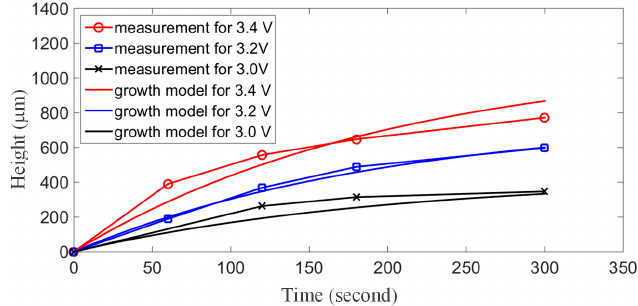
Figure 10. Hydrogel’s height given by hydrogel’s growth model and measured during experiments. The results demonstrate that hydrogel’s growth model can reflect the overall change of hydrogel’s height over time.